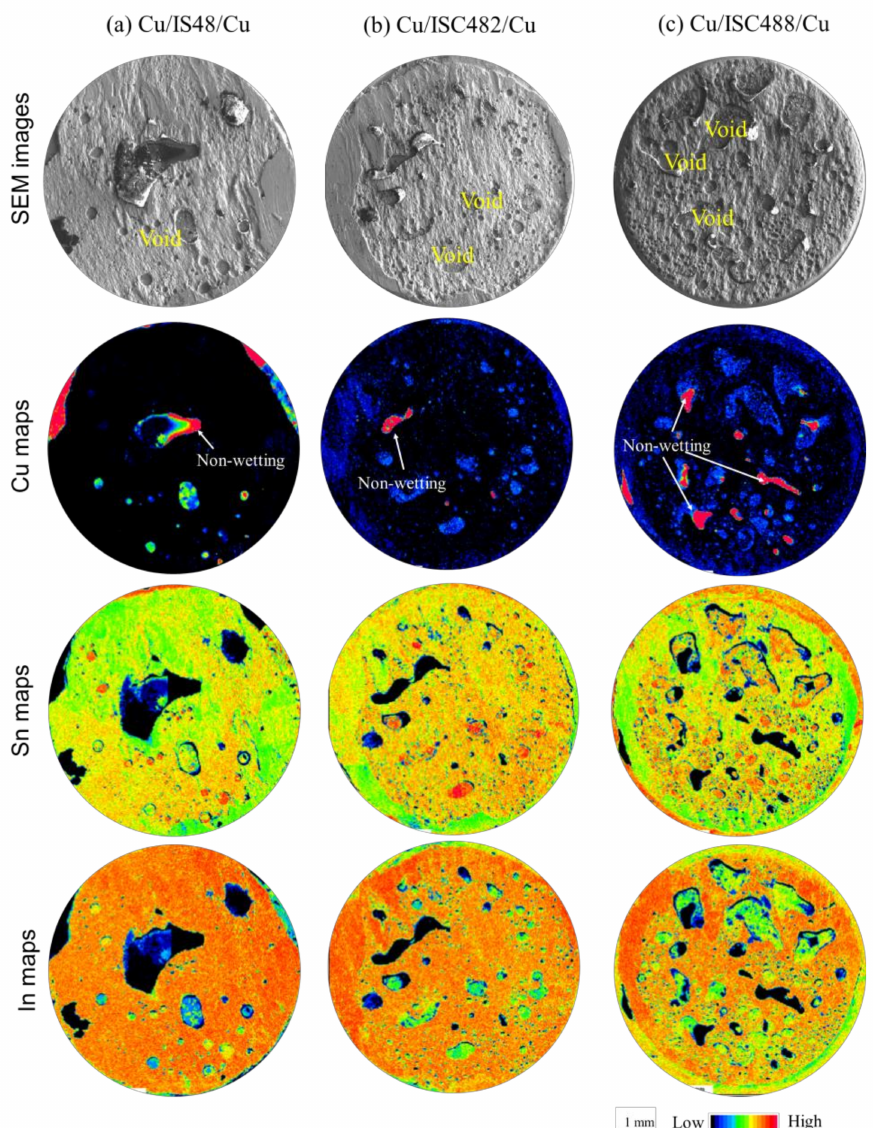
Figure 9. Top view SEM images of the fractured samples at the bottom disks after the shear test: ( a ) Cu/IS48, ( b ) Cu/ISC482, and ( c )